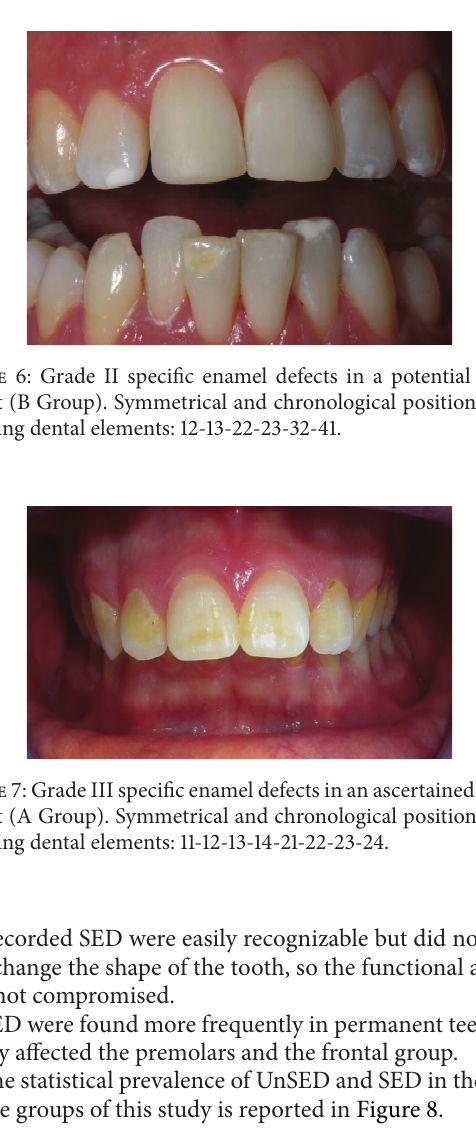
Figure 5: Unspecific enamel defects (white spots) upon the incisal edge of the upper left central incisor in ascertained coeliac patient (A Group).